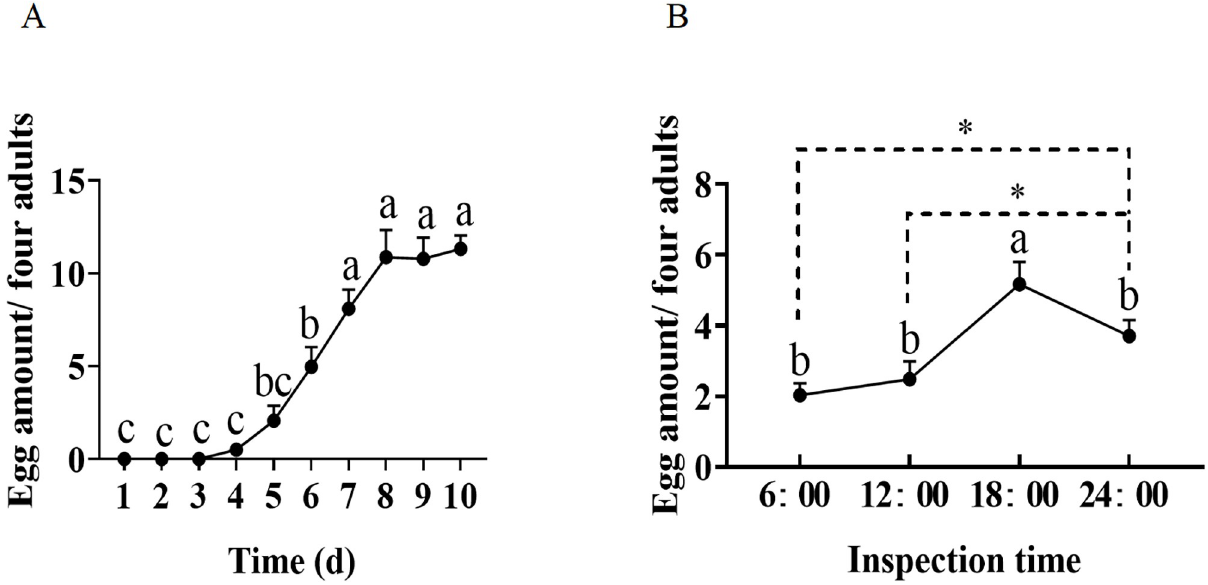
Fig 5. Investigation of oviposition dynamics of daily rhythm (A) and circadian rhythm (B). Data are from mean (+SE). For each time point, different letters indicate significant differences among treatments ( P < 0.05, Tukey’s honest significant difference (HSD) post-hoc test, n = 20). � indicates significant difference at P < 0.05 level by student’s t